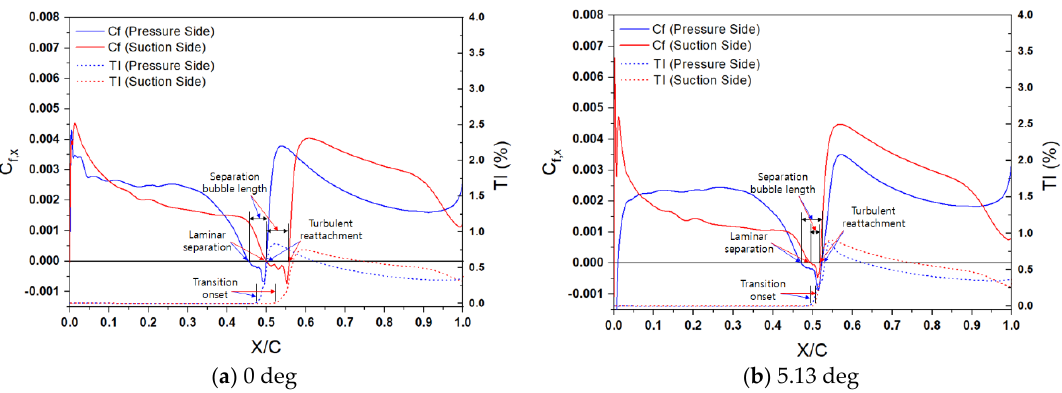
Figure 7. Comparison of x-direction skin friction coefficient ( 𝐶 𝑓,𝑥 ) and turbulence intensity (TI) at the AoAs of 0° ( a ) and 5.13° ( b ) for both surfaces of the airfoil (pressure and suction sides).